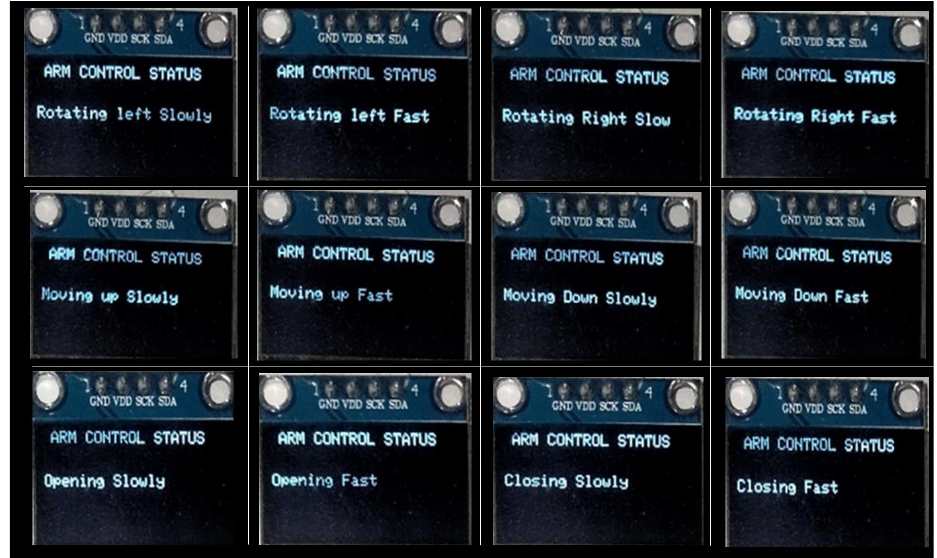
Figure 6. Status of the robotic arm motors with reference to the force applied (low or high) on the respective touch sensor of the CPS, keypad-based HMI.